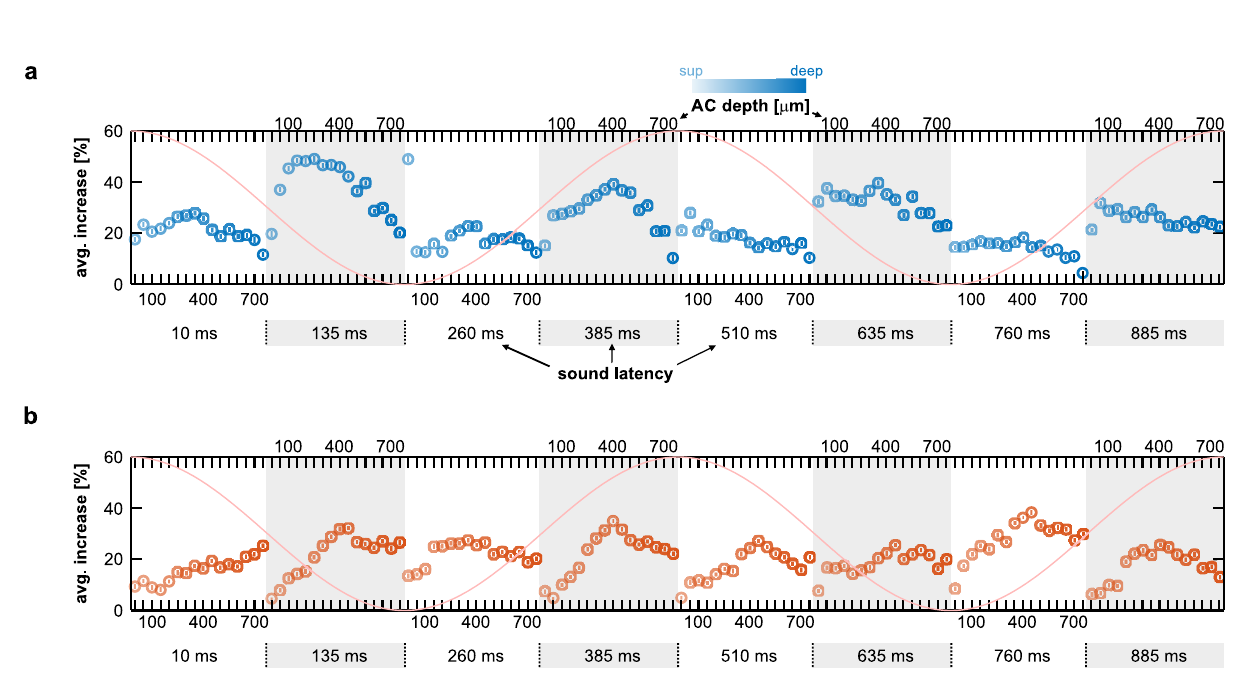
Fig. 4 Electrical stimulation of the FAF increases response strength in AC. a Schematic representation of the paradigm for electrical and acoustic stimulation. The timestamps for acoustic stimulation (colored according to latency; see also panels e – g ) represent the latency of sound onset relative to the end of electrical stimulation train. b Oscillograms of the natural distress syllable and echolocation pulse used for acoustic stimulation. On the right, the normalized power spectra of both calls are shown (orange, distress; blue, echolocation). c Broadband (0 – 20 kHz), raw data recorded simultaneously from FAF and AC (at representative depths of 50, 250, and 600 μ m) illustrating a single trial of electrical stimulation. Note that no electrical artefacts are visible in AC. d Auditory cortical LFPs (left column), and time-course of their energy (right), in response to either the distress syllable (top) or the echolocation pulse (bottom). Responses corresponding to the no-Estim condition shown in blue; responses related to the Estim condition, in red. e Strength of auditory cortical ERPs in response to the distress syllable, across all recorded columns ( n = 20 independent penetrations) and depths. In blue, responses associated to the no-Estim condition; in red, those associated to the Estim condition (data as mean ± s.e.m). f Corrected p -values obtained after statistical comparisons between response strengths related to Estim and no-Estim conditions, across all channels and latencies (paired, two-sided FDR-corrected Wilcoxon signed rank tests, alpha = 0.05). g , h Same as in e , f , but dealing with responses to the echolocation pulse. i Proportion of iterations (out of n = 500 total iterations) in which responses associated to the Estim condition were signi fi cantly larger than those associated to the no-Estim condition (same test as above). Data are presented across all channels and latencies analyzed, for responses to the distress and echolocation sounds. j Median effect size (Cliff ’ s delta) for the same comparisons summarized in ( i ). Source data are provided as a Source Data fi le.